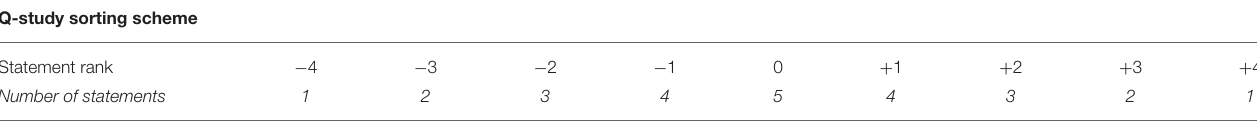
TABLE 2 | The research design for sorting 25 statements relative to one another, from most disagreeable ( − 4) to most agreeable ( + 4), with neutral in the middle (0). Q-study sorting